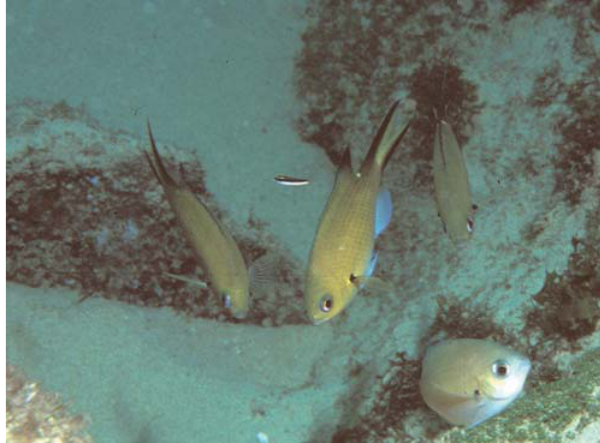
Fig. 4. Two sub-groups of the glassy sweeper ( Pempheris schomburgki ) hovering in the open, each sub-group being cleaned by a Noronha wrasse ( Thalassoma noronhanum ) (elongate fish with dark dorsum and white belly mingled with the